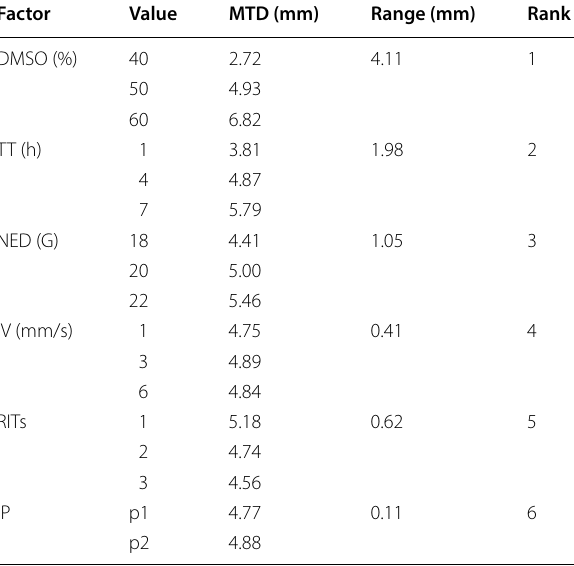
Table 5 Average value and range calculation of MND